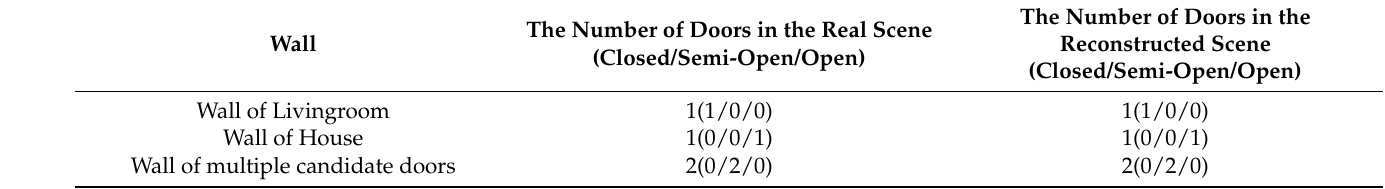
Table 4. Comparison of reconstruction